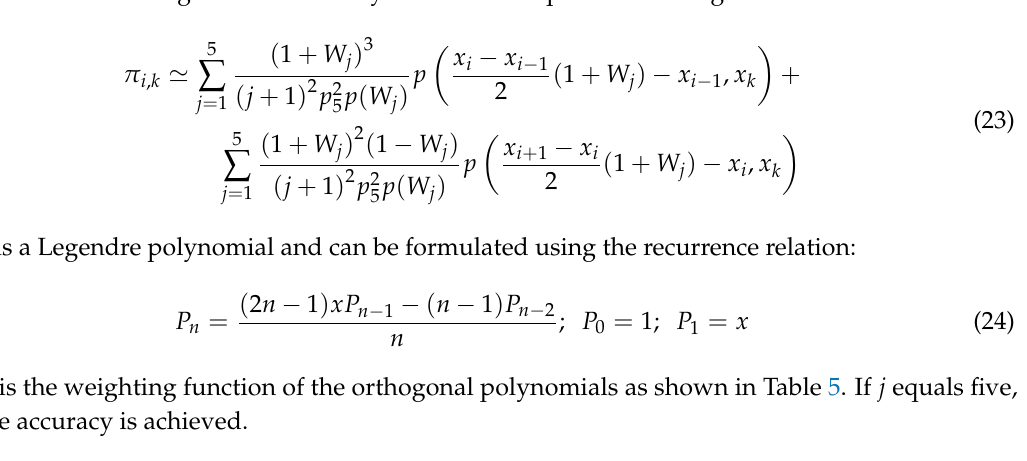
Table 5. Values of weights used in Gaussian quadrature.